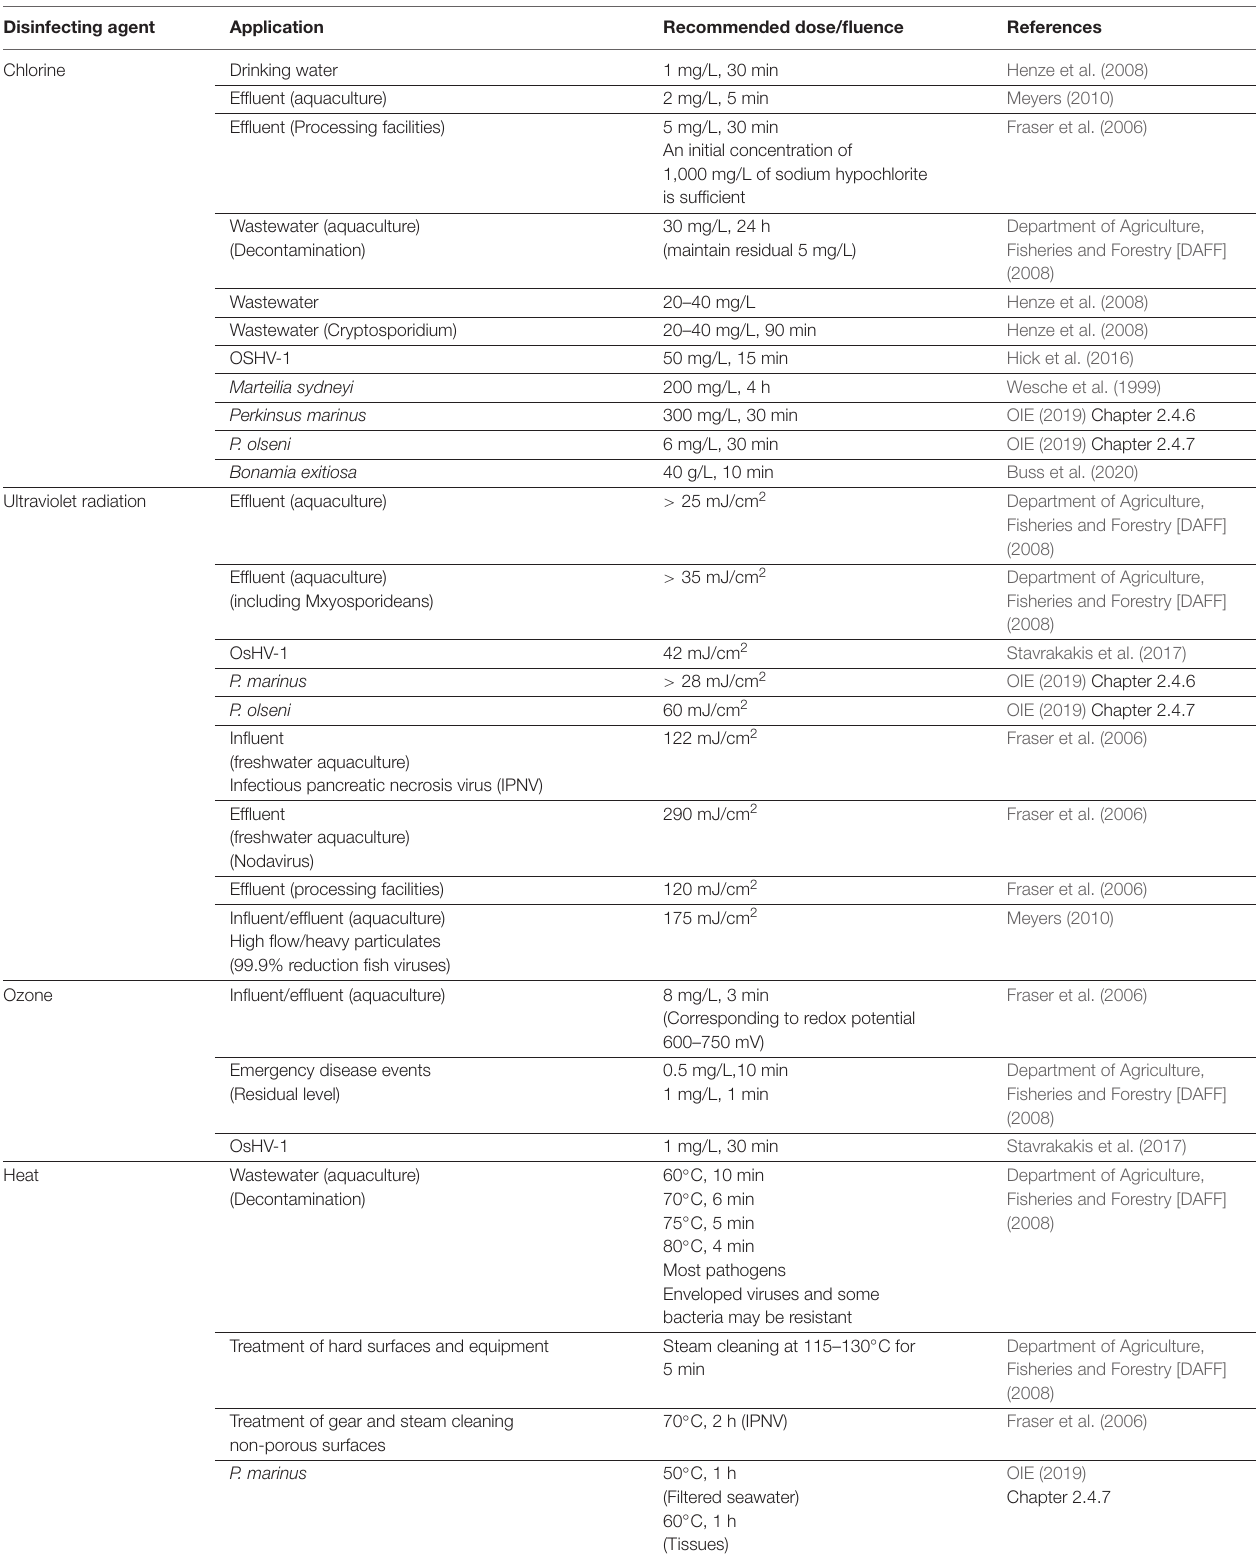
TABLE 5 | Recommended dose/fluence for efficacy of common water treatment